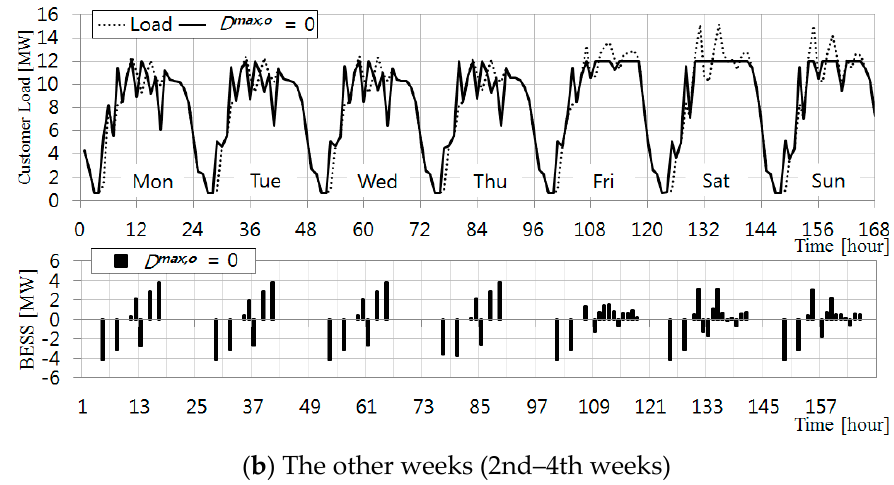
Figure 9. Daily operation results for the customer electric bill minimization which does not consider the historical peak-value.